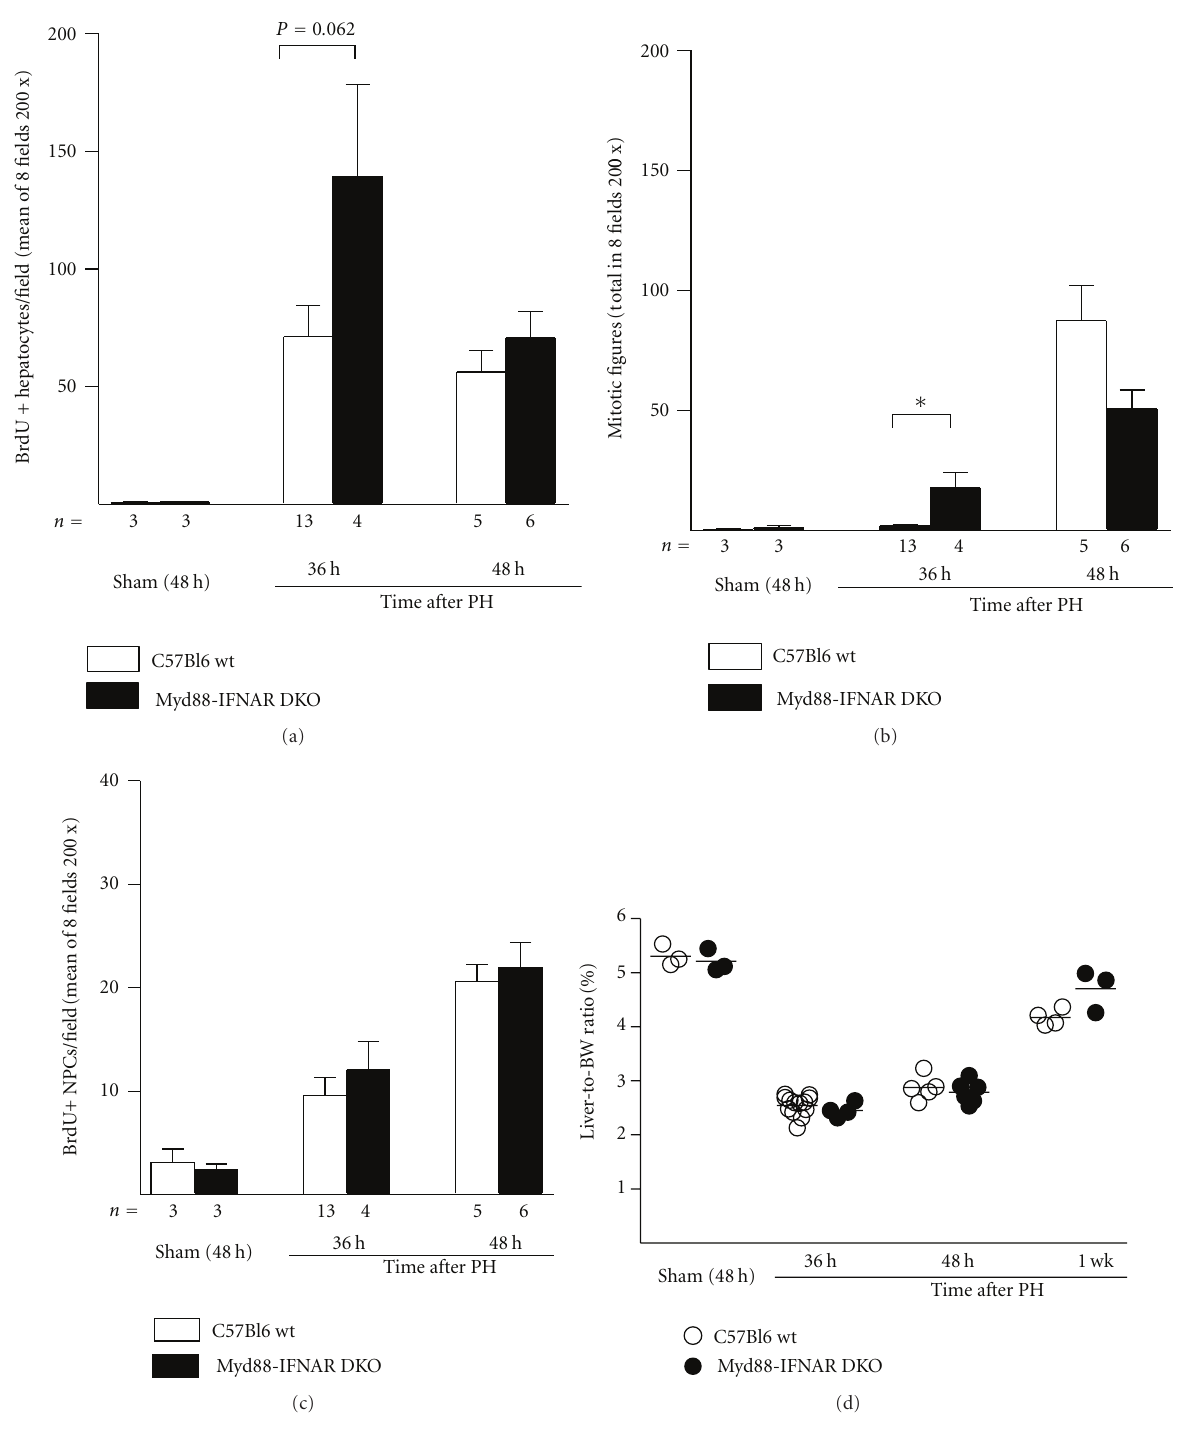
Figure 3: Liver regeneration after PH in C57Bl6 WT and Myd88-IFNAR double-KO mice without preexisting liver lesions. Shown are (a) the mean number of BrdU-labeled hepatocytes, (b) the total number of mitotic figures in hepatocytes, and (c) the mean number of BrdU- labeled nonparenchymal liver cells (NPCs), counted in eight 200x microscopic fields per mouse liver in C57Bl6 WT mice (white bars) and in Myd88-IFNAR double-KO mice (black bars) at the indicated times after PH or sham laparotomy. The number of mice in each group is indicated below the x -axis. ∗ P < 0 . 05. (d) Liver-to-body weight ratios in C57Bl6 WT (white circles) and Myd88-IFNAR double-KO mice (black circles), measured at the indicated time points after PH or sham